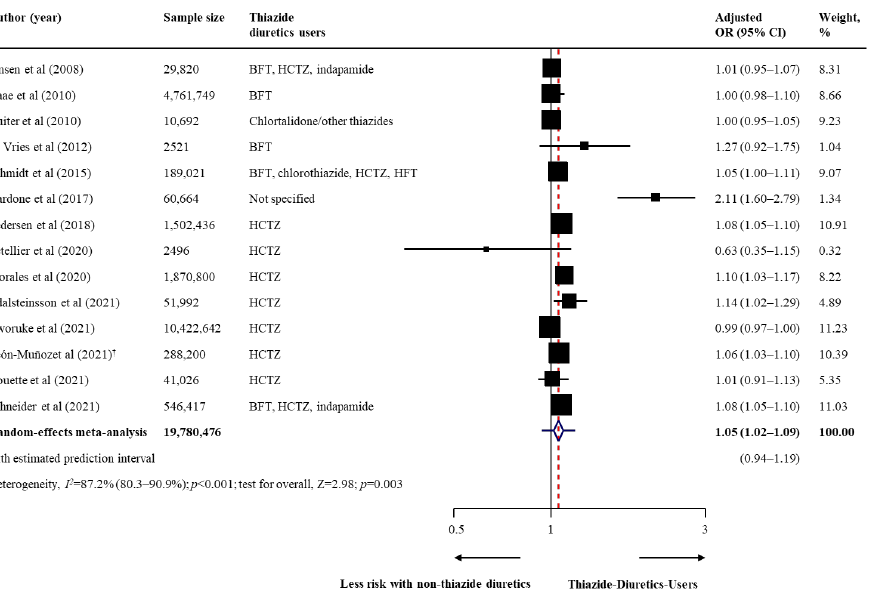
Figure 3. Effect of the use of thiazide diuretics and the risk of squamous cell carcinoma. Abbrevia- tions: BFT, bendroflumethiazide; CI, confidence interval; HCTZ, hydrochlorothiazide; HFT, hydro- flumethiazide; OR, odds ratio [30,31,33,36–38,40,42,47,48,50,51,53,56–58].